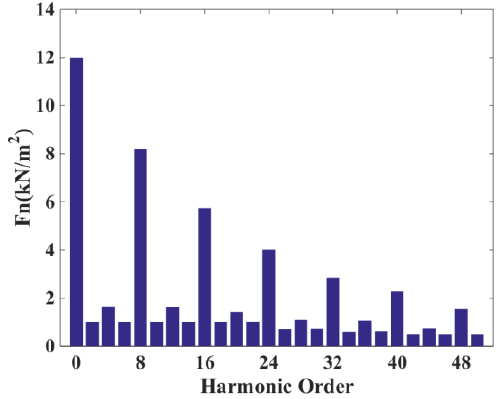
Figure 14. Radial electromagnetic force time decomposition of the DDSRG.